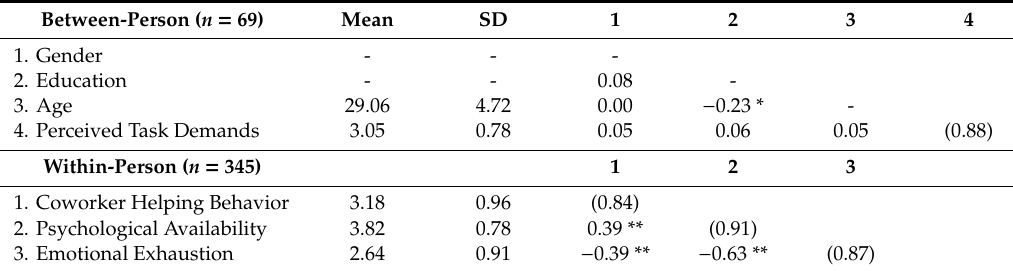
Table 2. Descriptive statistics and correlation